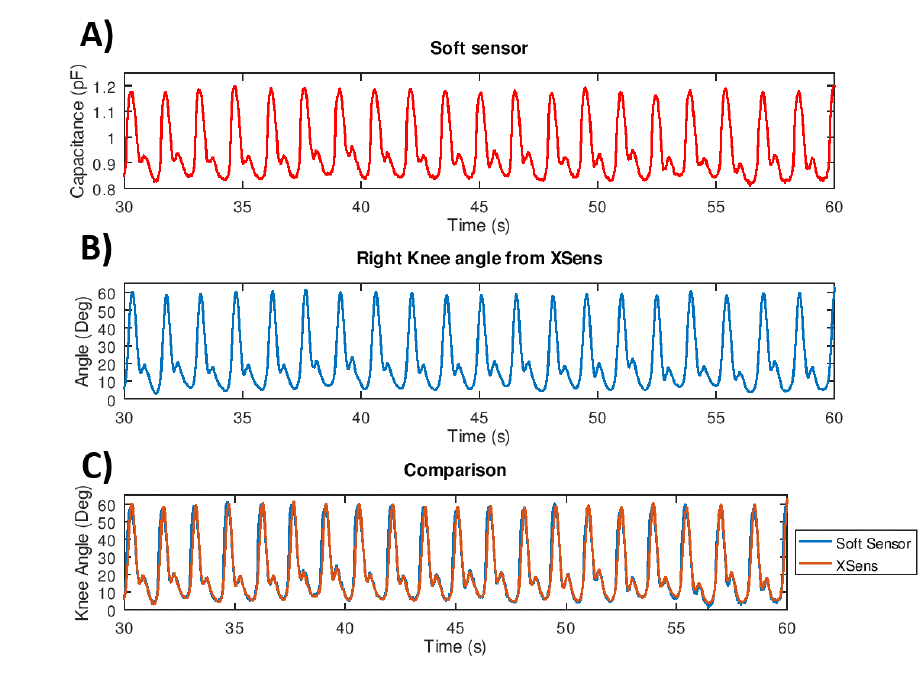
Figure 6. ( A ) Soft sensor output. ( B ) Knee angle measured by the XSens system. ( C ) Comparison between soft sensors (blue solid line) and XSens system (red solid line), using a linear combination for fitting the knee